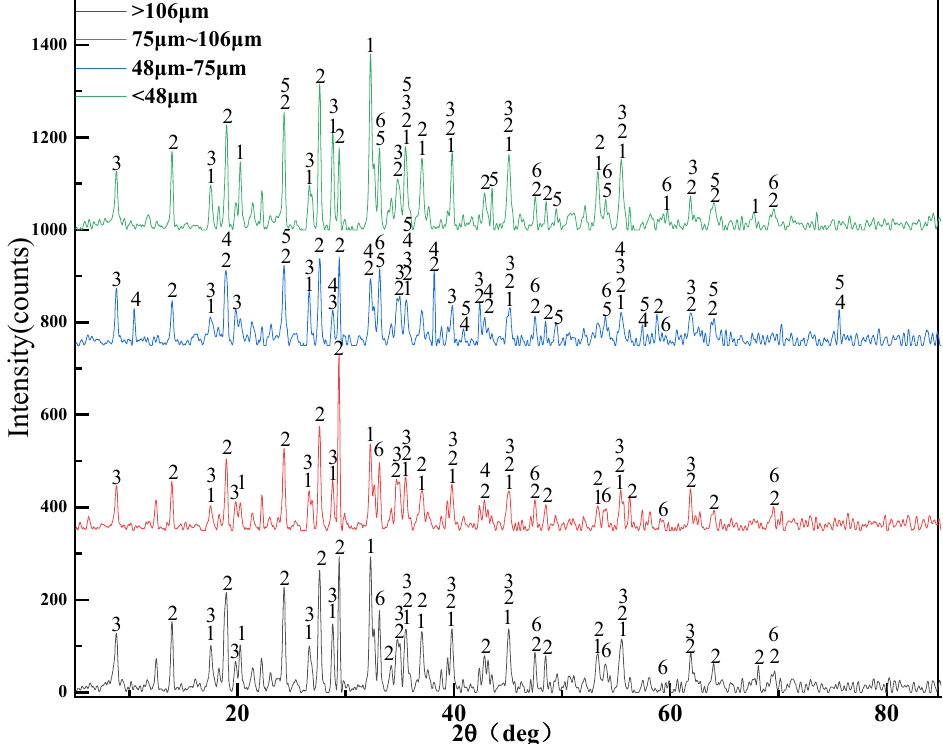
Figure 4. XRD pattern of the red-mud sample with different particle sizes (1—Ca 3 Al 2 (SiO 4 )(OH) 8 ; 2—Na 6 Ca 2 Al 6 Si 6 O 24 (CO 3 ) 2 2H 2 O; 3—(K,Na)(Al,Mg,Fe) 2 (Si 3.1 Al 0.9 )O 10 (OH) 2 ; 4—Fe 7 Si 8 O 22 (OH) 2 ; 5—Fe 2 O 3 ; 6—CaTiO 3 ).